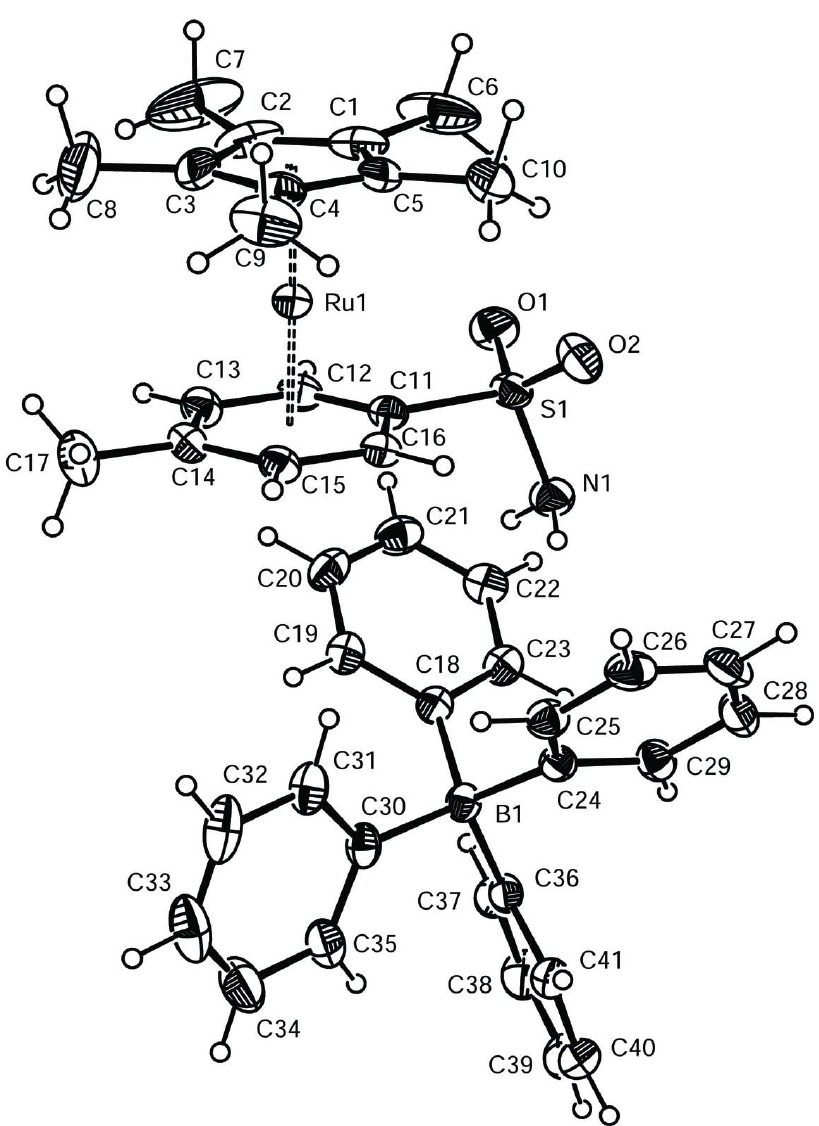
Figure 1 The structure of (I), with atom labels and 30% probability displacement ellipsoids for the non-H